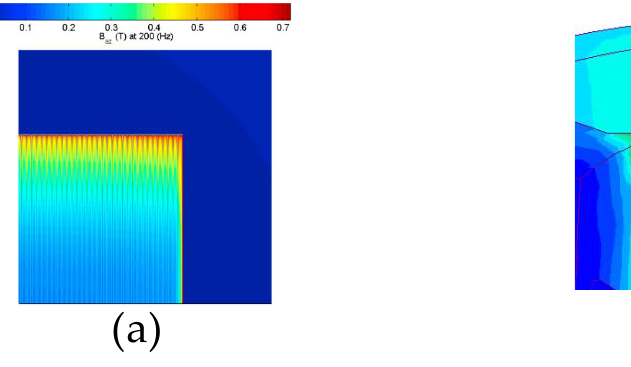
Figure 5. Iron sheet Effects. ( a ) Lamination effect [83]. ( b ) End effect